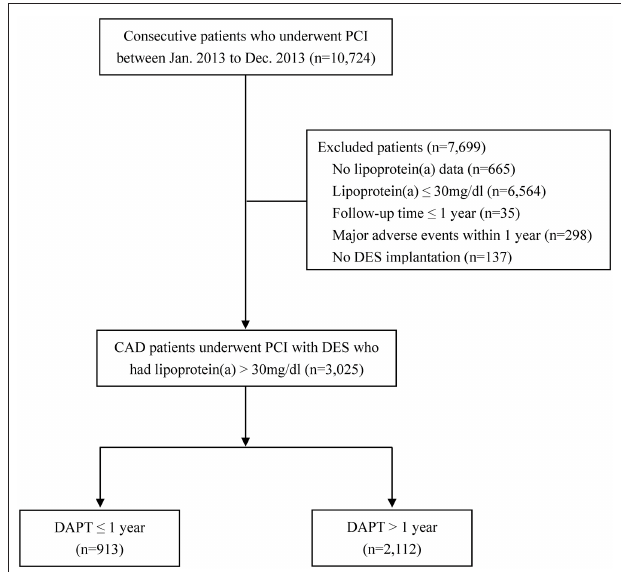
FIGURE 1 | Flow chart of the study. CAD, coronary artery disease; DAPT, dual antiplatelet therapy; DES, drug-eluting stent; PCI, percutaneous coronary